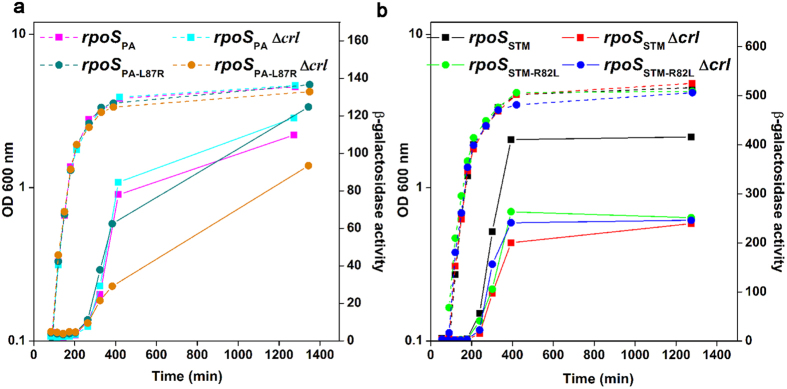
Expression kinetics of the katN-lacZ transcriptional fusion in S. Typhimurium strains harbouring different rpoS alleles.Growth (dashed lines) and β-galactosidase activities (solid lines) of the S. Typhimurium strains indicated, harbouring wild-type and mutant rpoS alleles from P. aeruginosa (a) and S. Typhimurium (b). Aliquots were taken at different time intervals during growth and β-galactosidase activity was measured in Miller units. Aliquots were also used for σS immunodetection (Supplementary Fig. S3b). The growth phase was determined by the measurement of culture turbidity at OD 600 nm. The experiments were repeated twice with similar results.